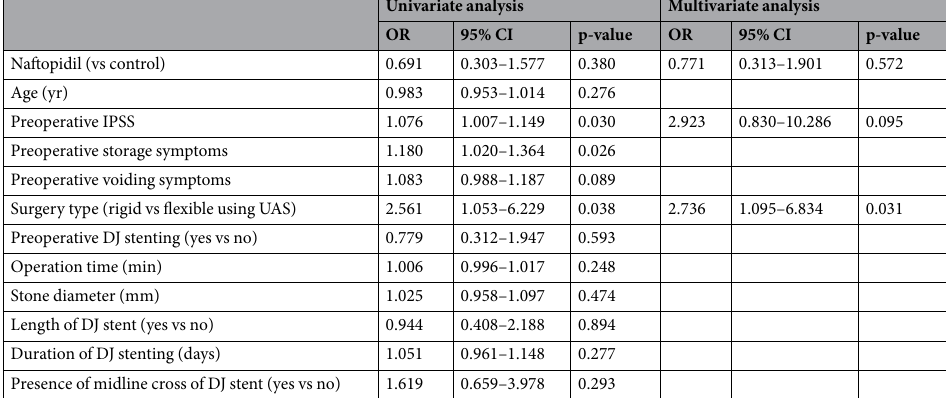
Table 3. Multivariate logistic analysis to find the predictor of double J ureteral stent related pain based on USSQ pain score. USSQ, Ureteral stent symptom questionnaire; OR, odds ratio; CI, confidence interval; IPSS, international prostate symptom score; DJ, double J; UAS; ureteral access